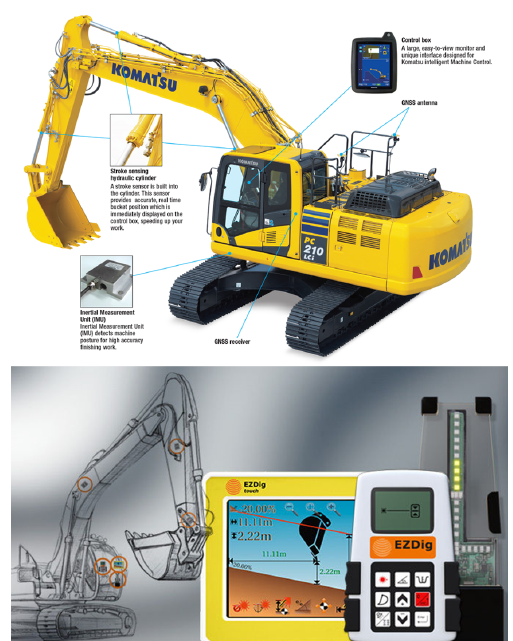
Figure 1. ( top ) Machine guidance using measured cylinder length, which is developed by KOMATSU; ( bottom ) Machine guidance using measured links motion, which is developed by